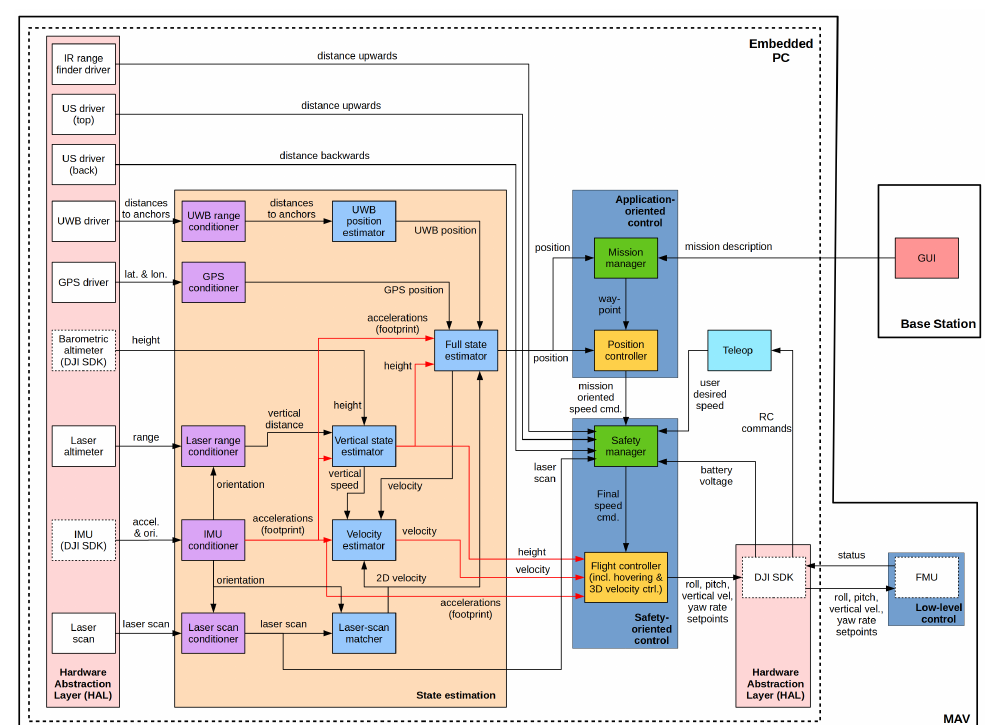
Figure 5. Detailed view of the control architecture of the aerial